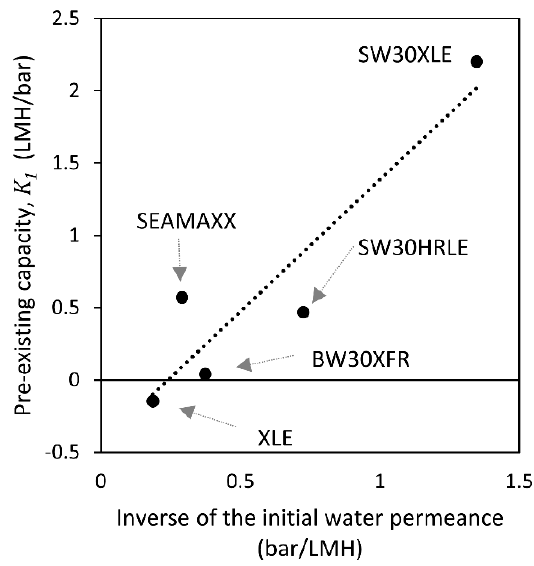
Figure 9. Estimated pre-existing capacity (at 5 min of contact) of the active layer from the dual-mode sorption model versus the inverse of the initial water permeance for each membrane. The dotted line is a guide for the reader ′ s eye.